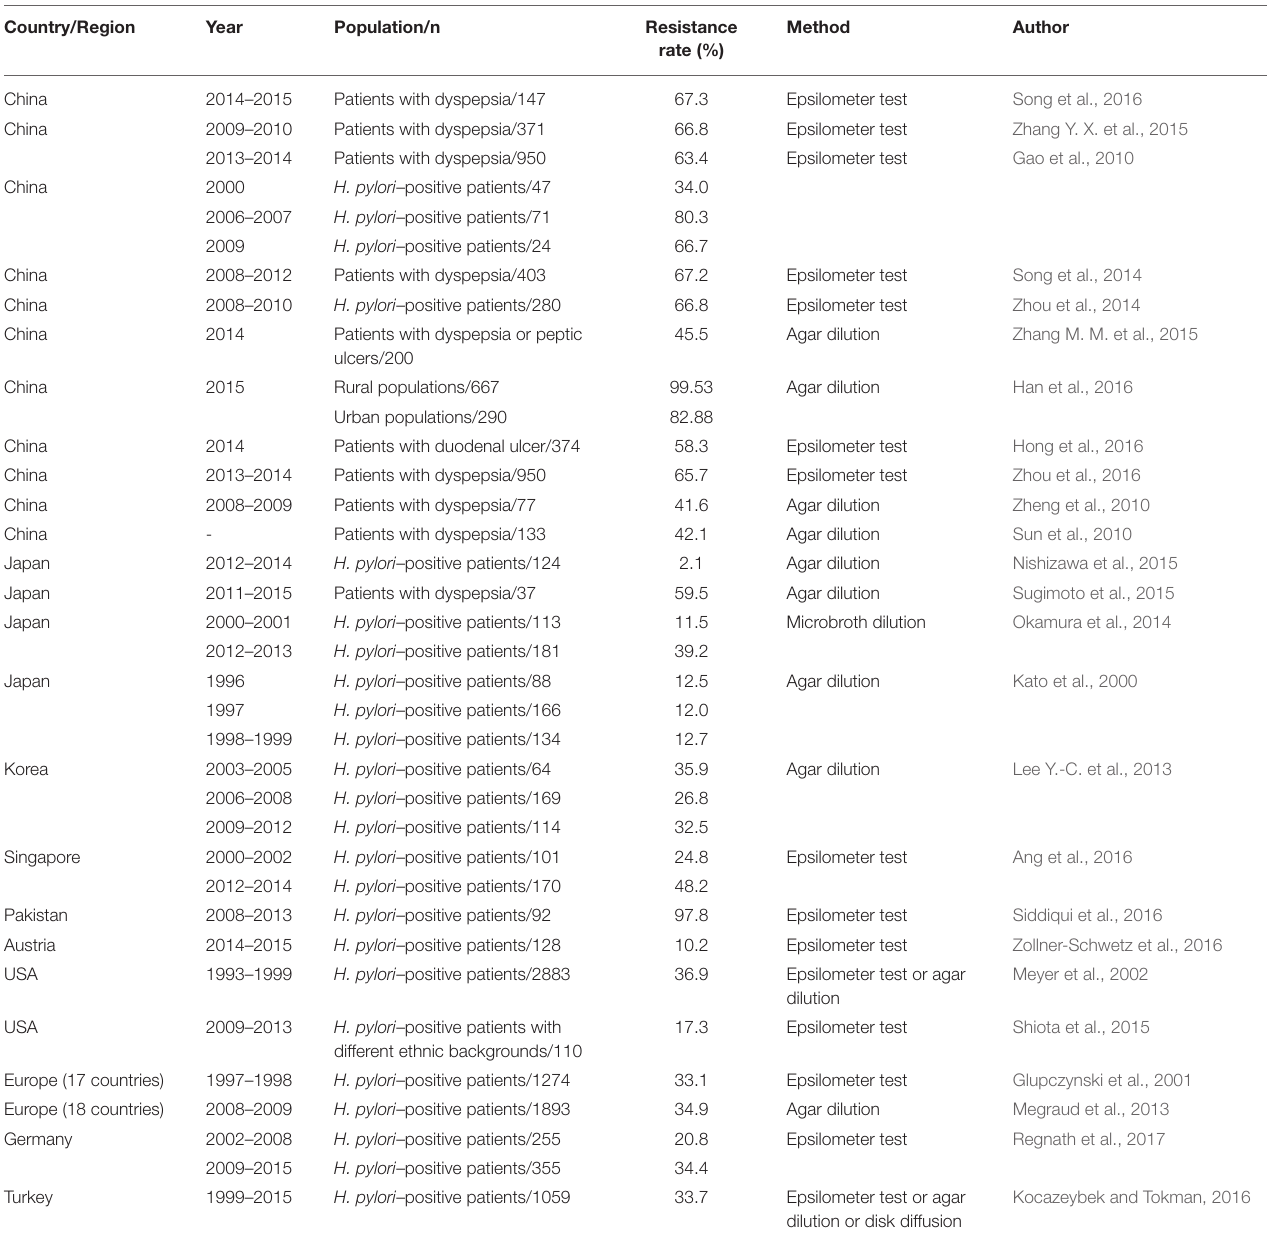
TABLE 3 | The primary metronidazole resistance of H. pylori .